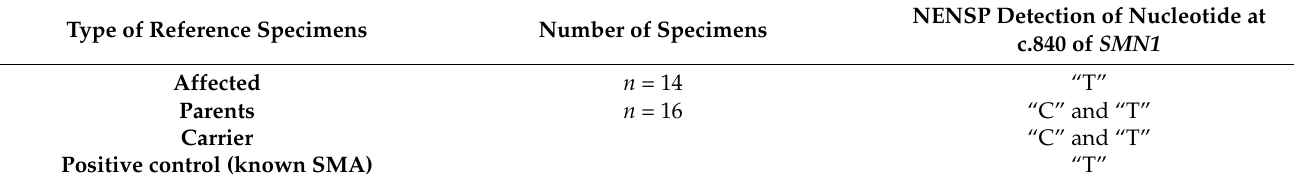
Table 1. NENSP genotype determinations of reference specimens used for validation of SMA sequencing. Type of Reference